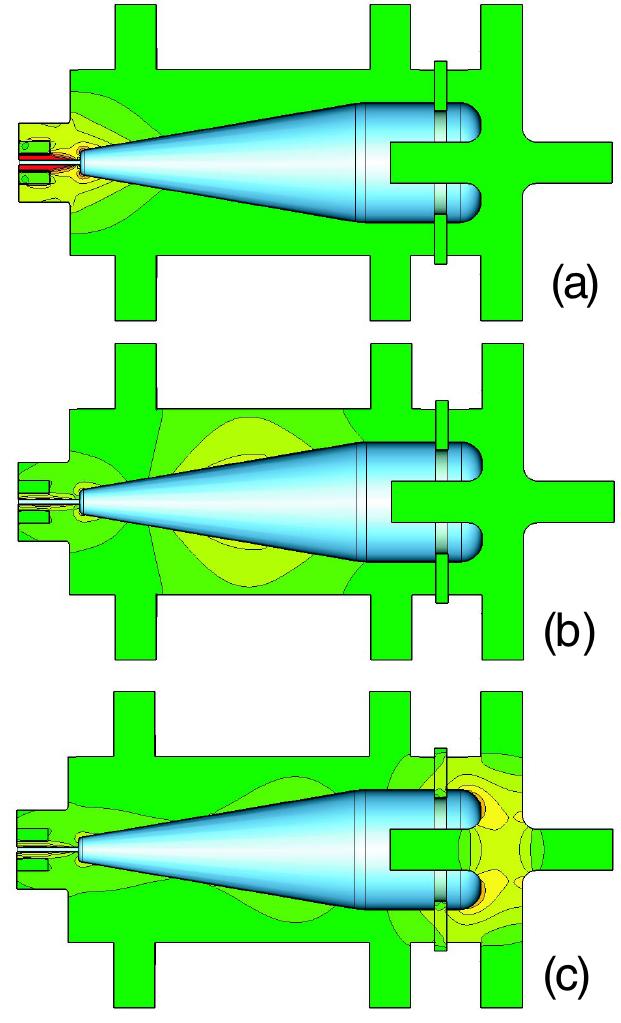
FIG. 4. (Color) CST-MICROWAVE STUDIO simulation for a pulse with a rise time of 150 ps. (a) The pulse at the entrance; (b) the pulse halfway through the accelerator; (c) the pulse reaches the acceleration point. In these pictures the vacuum is visualized. The electric field strength is indicated by colors. Red is the maximum electric field strength and green minimum.